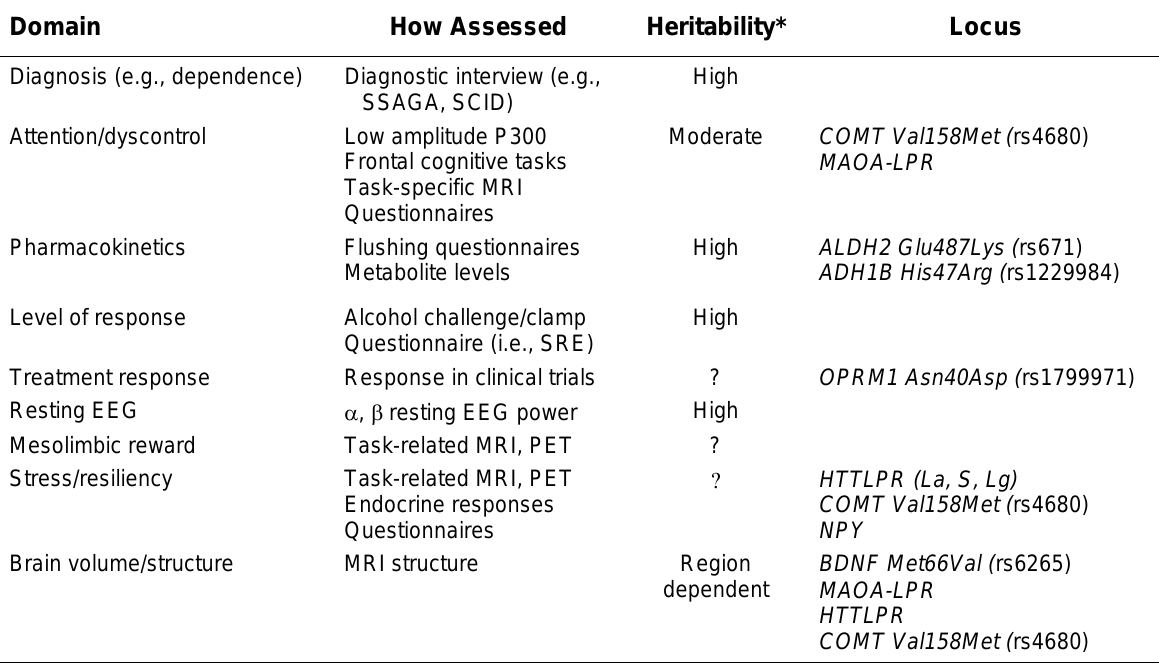
Intermediate Phenotypes for